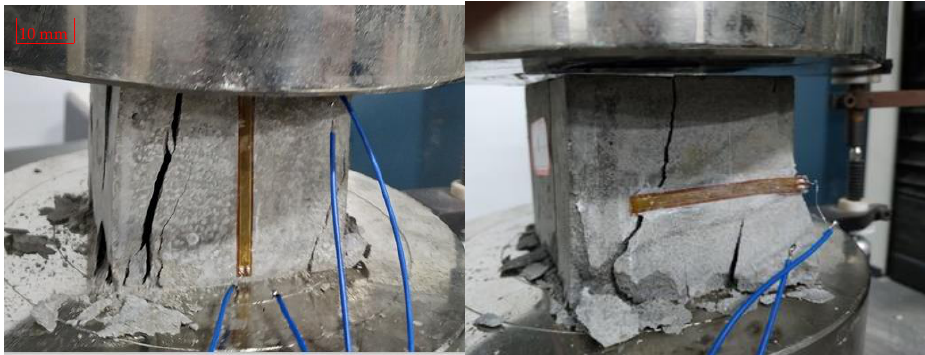
Figure 2. Static compressive strength and Poisson’s ratio of similar materials were tested.